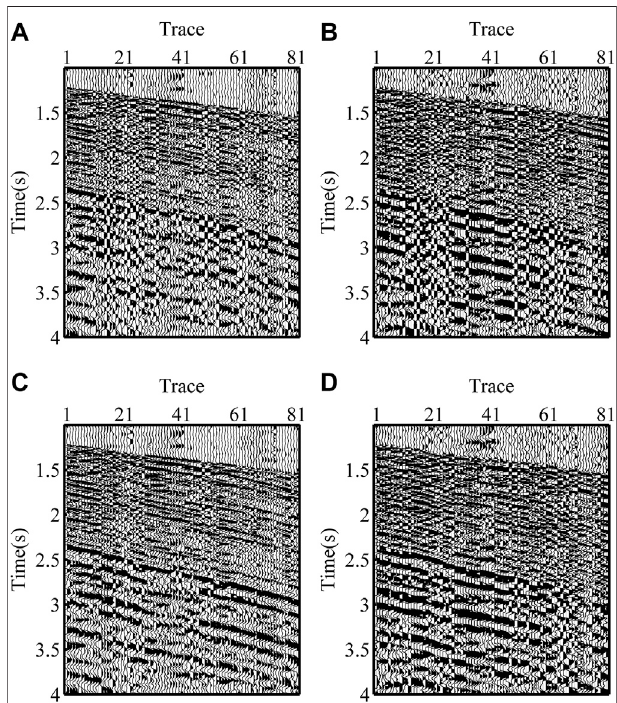
FIGURE8| Fieldseismicdataafterrotation. (A) R-and (B) T-component VSP data generated by the eigenvalue method. (C) R- and (D) T-component generated by the scalar fi eld